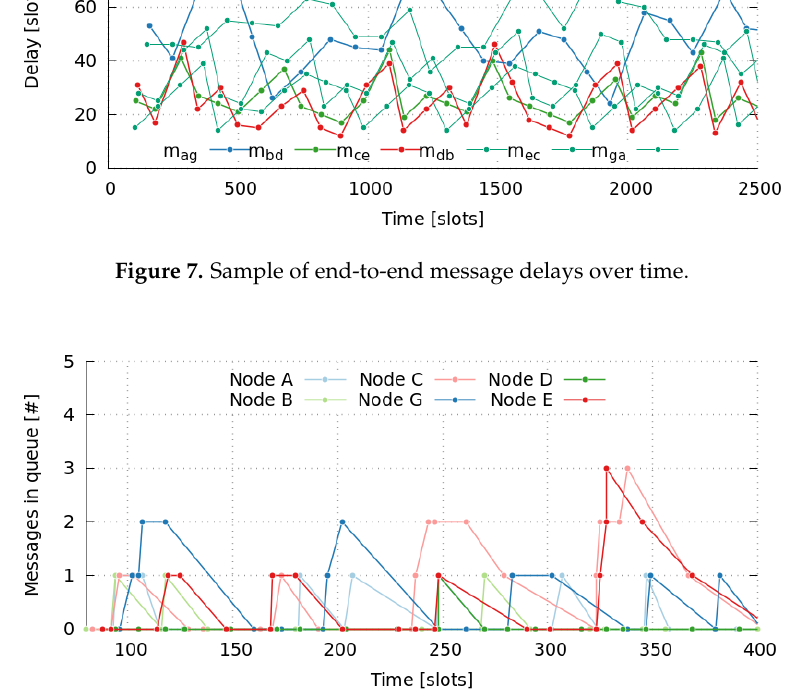
Figure 8. Sample of node queue length.